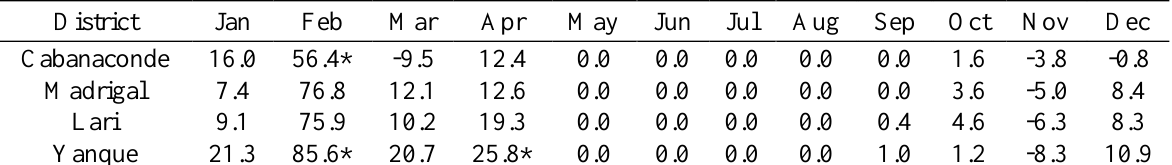
Table A 1 .1. Trends in Monthly Cumulative Precipitation (mm) over the Period of 1988 to 2017 for the Different Districts District Jan May Dec Cabanaconde Madrigal